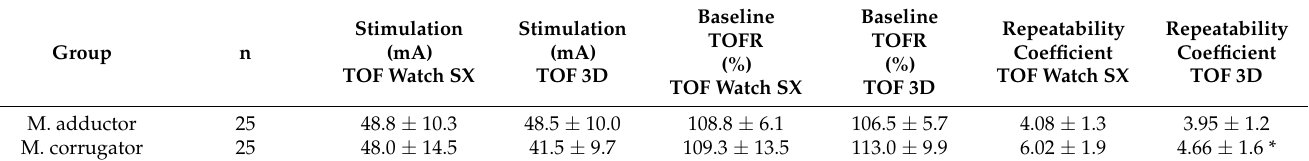
Table 1. Baseline